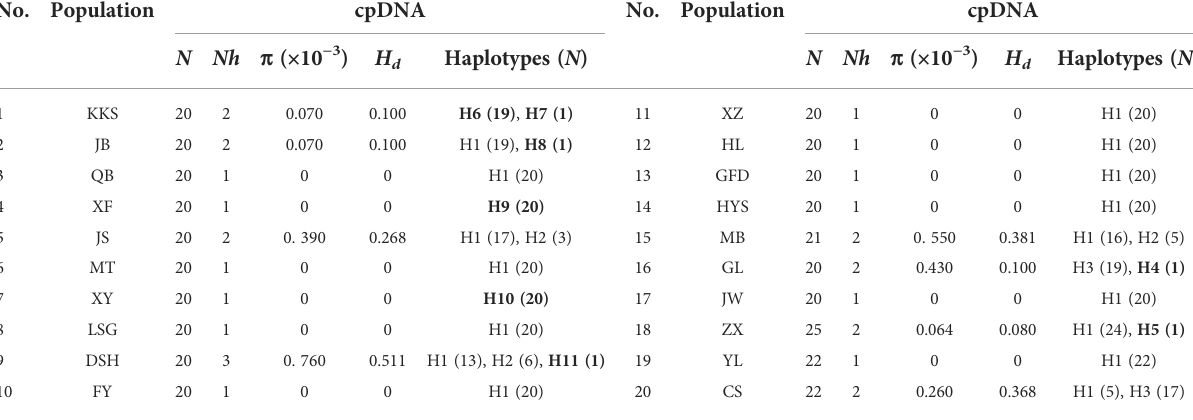
TABLE 2 Distribution and genetic diversity parameters of cpDNA haplotypes in Ch. utilis .